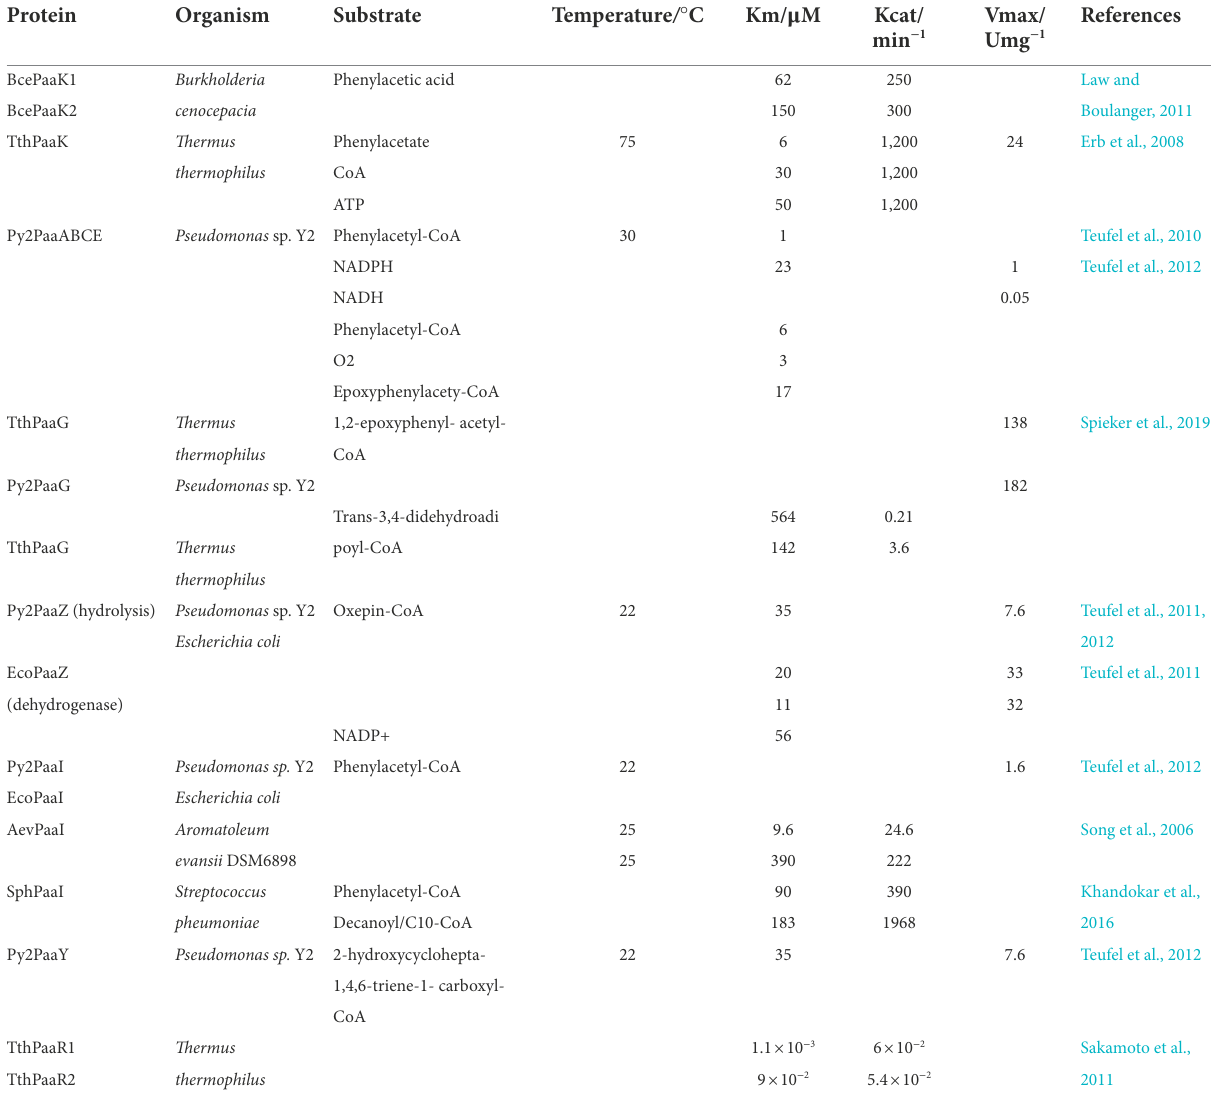
TABLE 1 Overview of the catalytic properties of PAA